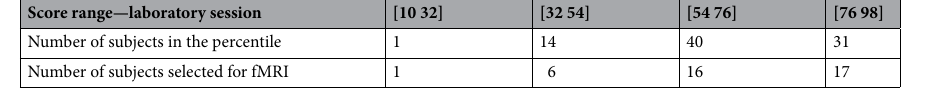
Table 1. Selection of subjects for fMRI session. 1st row: upper and lower boundaries of each class of performance obtained in the laboratory testing session (no feedback session); 2nd row: number of subjects in the corresponding class; 3rd row: number of subjects selected for the fMRI